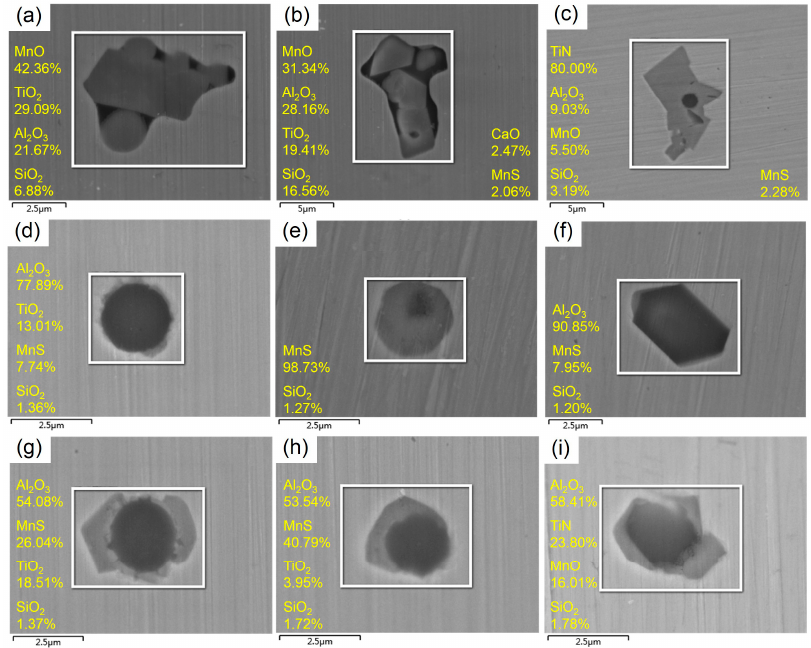
Figure 7. Morphology and composition of typical inclusions in samples of electrode and ESR ingot: ( a – c ) electrode and ( d – i ) ESR